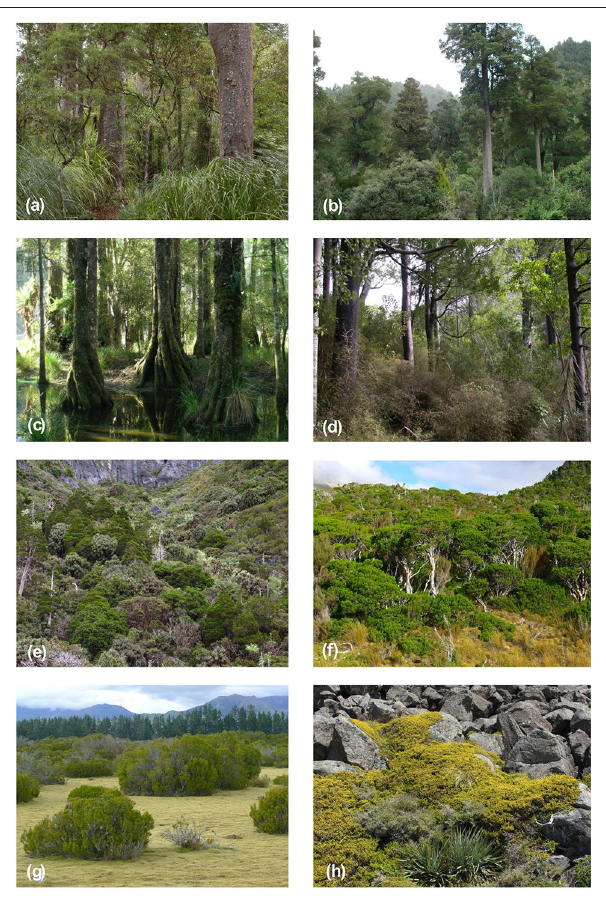
FIGURE 1 | Examples of New Zealand conifer growth forms and habitats. (a) Agathis australis -dominated forest, Puketi Forest, northern North Island (b) alluvial conifer forest on pumice soils with Prumnopitys taxifolia , P. ferruginea, and Dacrycarpus dacrydioides , Ngaputahi, central North Island (c) Dacrycarpus dacrydioides swamp forest, Arohaki Lagoon, central North Island (d) dryland Prumnopitys taxifolia forest with dense divaricating shrub understorey, Isolation Creek, north-eastern South Island (e) even-aged, landslide-induced Libocedrus bidwillii stand, Ghost Valley, north-west South Island (f) Halocarpus biformis shrubland at treeline, Hunts Creek, Westland (g) shrubby Halocarpus bidwillii on frosty, leached terraces, south-west South Island (h) prostrate Podocarpus nivalis , Kakanui Mountains, south-eastern South Island. All images by the authors except (h) from John Barkla sourced under CC-BY-NC from